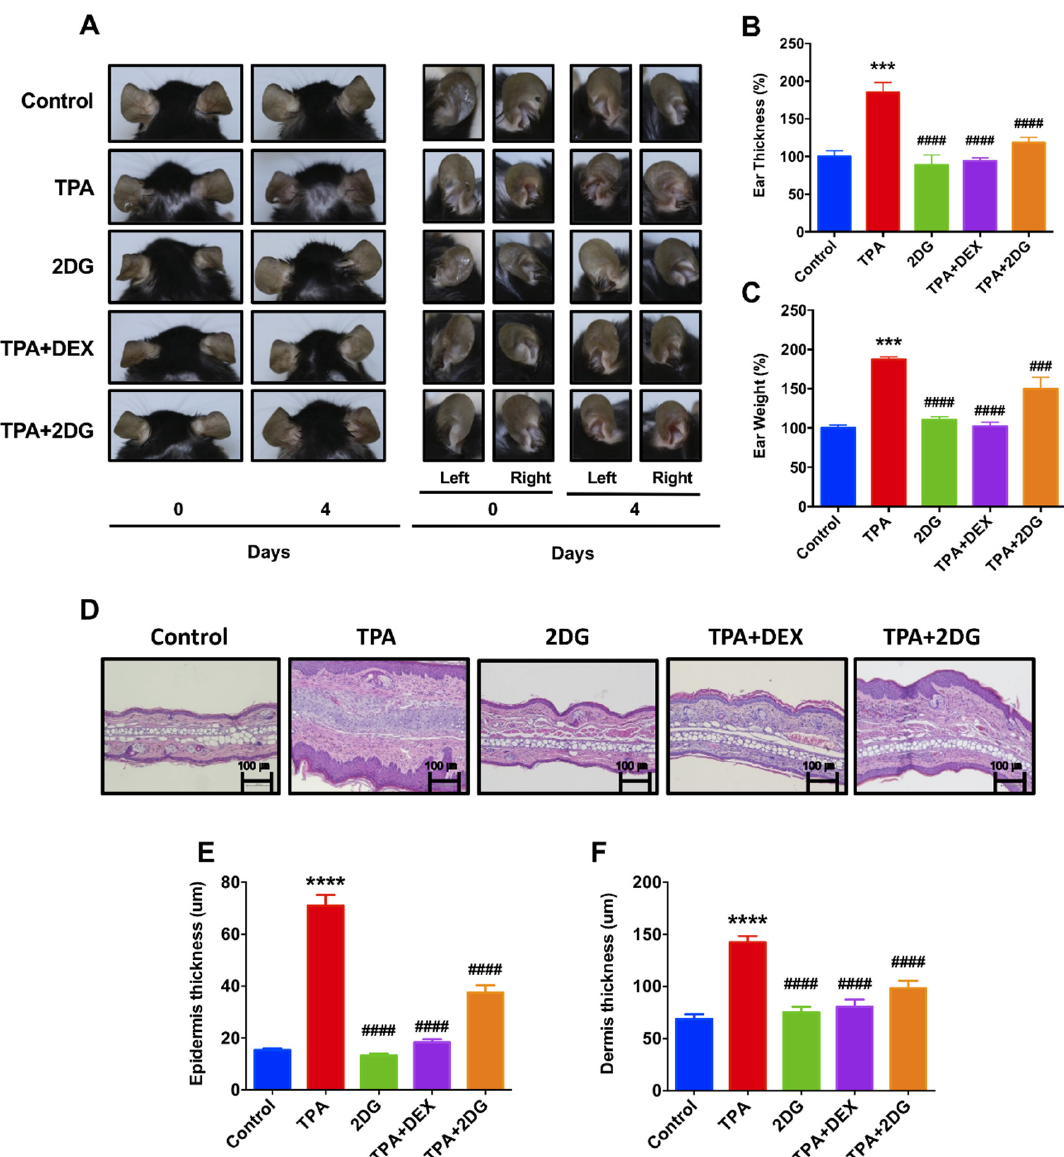
Figure 2. 2-deoxy-d-glucose (2DG) alleviates 12-o-tetradecanoylphorbol-13-acetate (TPA)-induced animal model of dermatitis. ( A ) Representative images of mouse ears of anterior and posterior surfaces at 0, 2, and 4 days. Control: Control group, TPA: TPA-treated group, 2DG: 2-deoxy-d-glucose treated group, TPA + DEX: TPA and Dexamethasone treated group, TPA + 2DG: TPA and